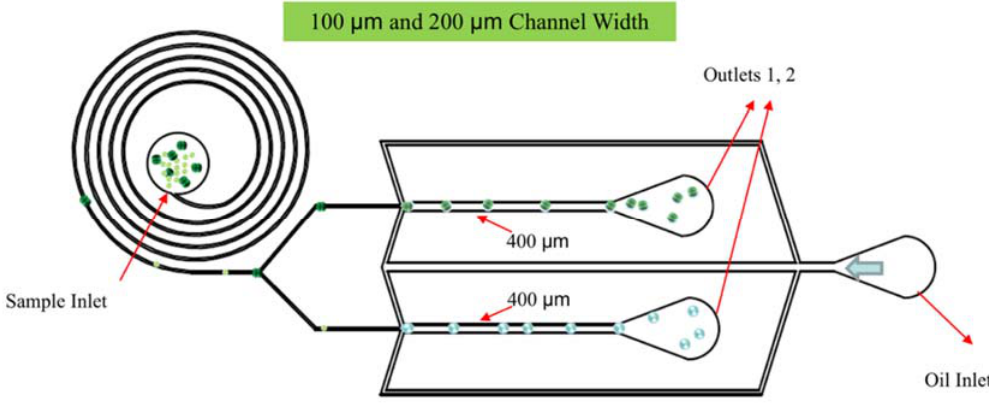
Figure 3. The whole microfluidic chip.